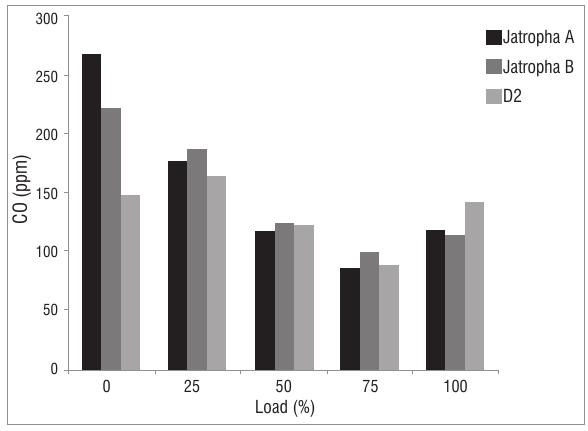
Figure 4: Carbon monoxide (CO) emissions for the different fuel samples at different loads.